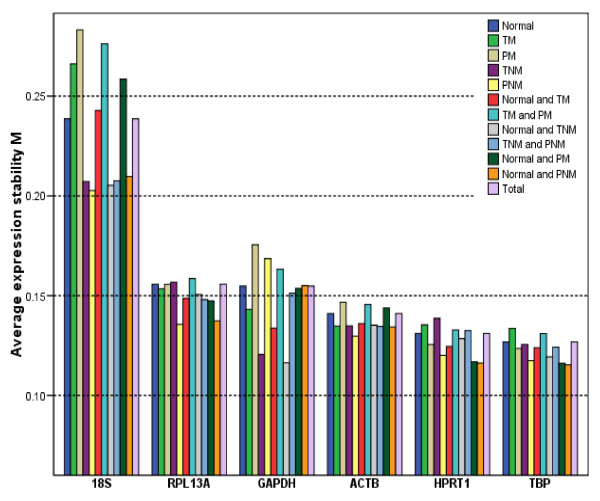
Selection of the most suitable reference genes using geNorm analysis. We performed geNorm analysis in variable combinations of each group according to different specific interest in cancer studies. The value of M was calculated for each gene, clustered in one group. The lowest M value characterizes genes with the most stable expression. The X-axis from left to right indicates the ranking of the genes according to their expression stability.